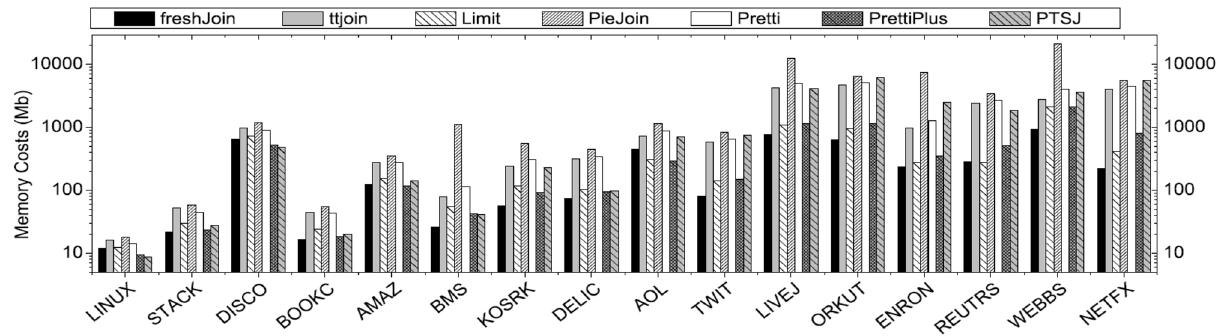
Fig. 6 The memory cost of different algorithms